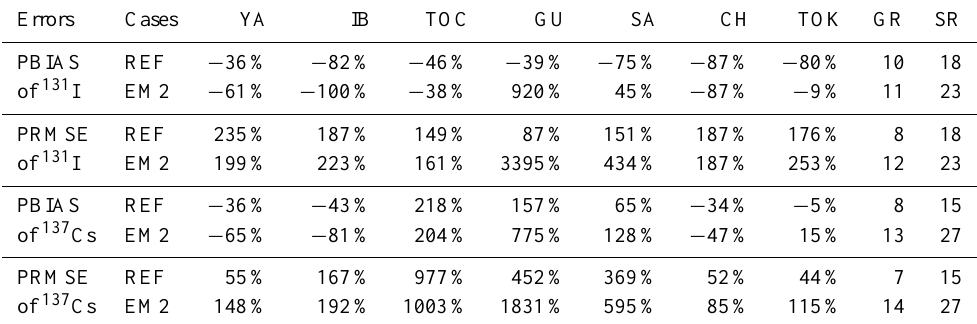
Table 8. The PBIAS and PRMSE of total daily depositions of 131 I and 137 Cs with different emission rates. GR represents the global ranks for PBIAS or PRMSE, and SR represents for the sum of the global ranks. The definition of GR and SR is shown in Sect. 3.1.2. “YA”, “IB”, “TOC”, “GU”, “SA”, “CH” and “TOK” represent the stations “YAMAGATA”, “IBARAKI’, “TOCHIGI”, “GUNMA”, “SAITAMA”, “CHIBA” and “TOKYO”, respectively.